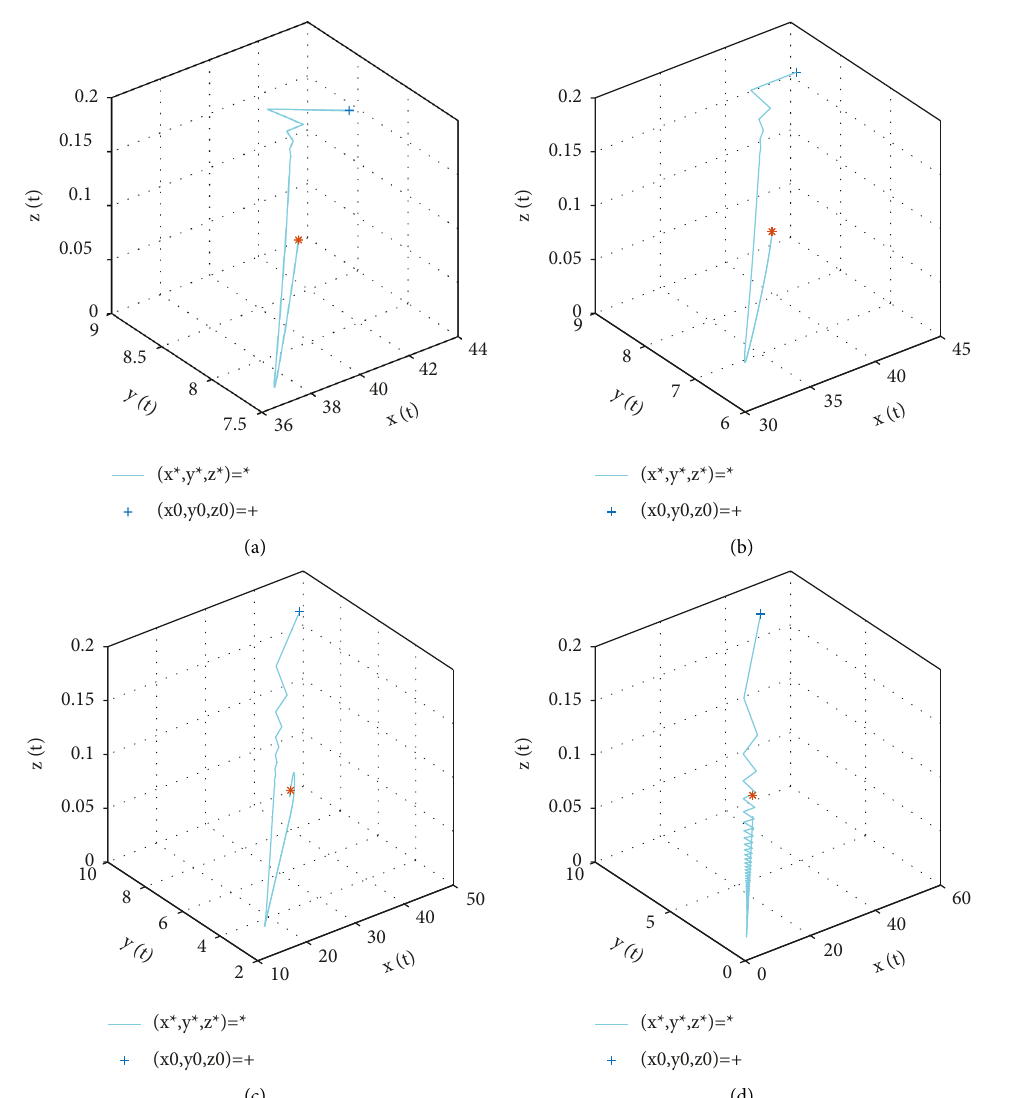
Figure 2: Shows the local stability of the equilibrium point e at which x ( t ) represents immature prey species, y ( t ) represents mature prey 3 species, and z ( t ) represents predator species. The values in Table 2 are used with different values of fractional-order(a) q � 1, (b) q � 0 . 98, (c) q � 0 . 88, and (d) q � 0 .